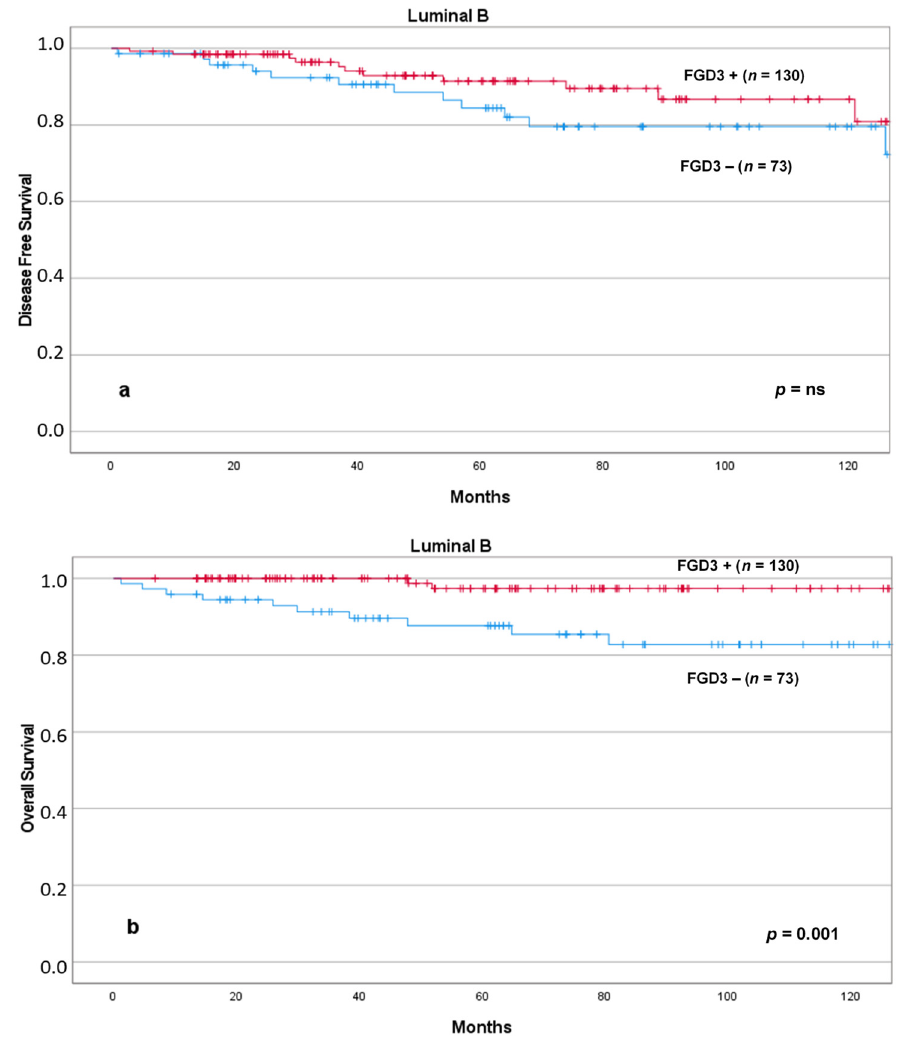
Figure 8. DFS ( a ) and OS ( b ) according to FGD3 expression in patients with Luminal B tumors. Abbreviations: FGD3+: high FGD3 expression; FGD3 − : low FGD3